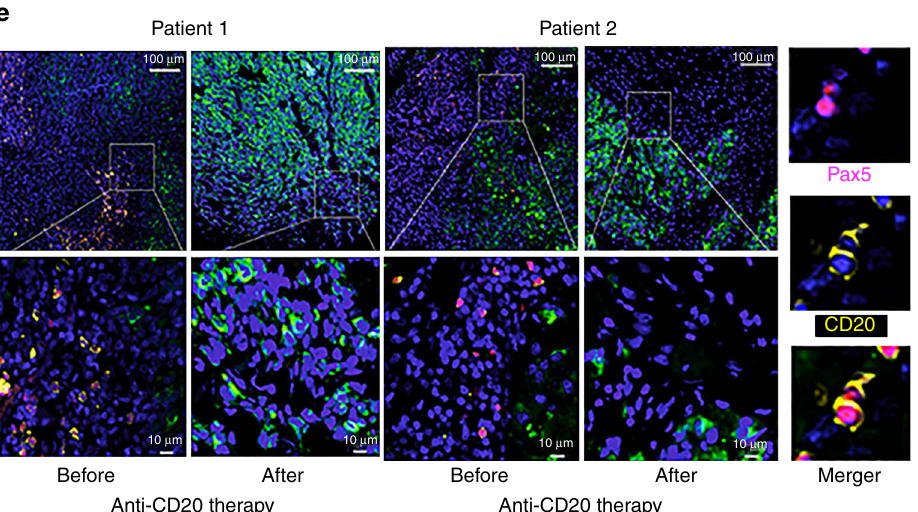
Fig. 8 Clinical activity of CD20 immunotargeting in metastatic melanoma patients. PET-CT scans from two different patients obtained pre- vs. post-anti- CD20 antibody therapy. a , b Note complete disappearance of a metabolically active metastatic site ( white arrow ); c , d mixed response with almost complete disappearance of one metabolically active metastatic site ( white arrow in d ) and simultaneous increase in size and metabolic activity of the other ( red arrow in d ). e Representative combined PAX5 (nuclear; purple )/CD20 (membrane; yellow ) immuno fl uoresence staining of patient-matched melanoma samples before and after therapy with anti-CD20 antibody (overviews ( top rows ; scale bars : 100 μ m) and corresponding close ups ( bottom rows ; scale bars : 10 μ m)). Note depletion of TAB cells in post-therapy tumors. CSPG staining of melanoma cells ( green ) and nuclear DAPI staining ( blue ). Right panel : double positive PAX5 (nuclear)/CD20 (membrane) immuno fl uoresent TAB